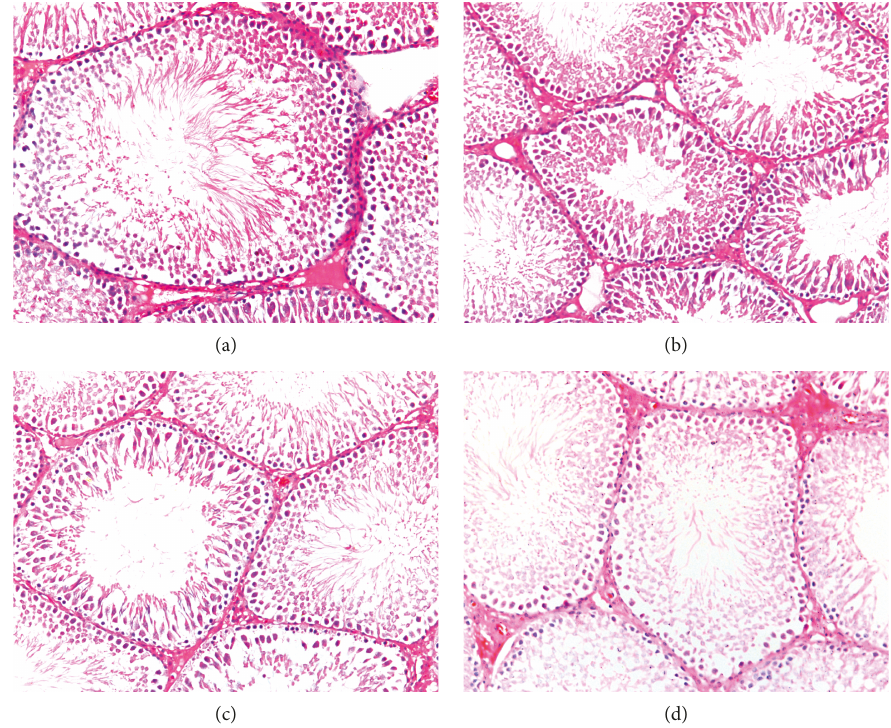
Figure 1: Representative photomicrograph of testis sections. (a, d) From the control groups. Note the regular arrangement of spermatogenic cells and seminiferous tubules. (b) From the CPA group. Note the nuclear pyknosis and cytoplasmic microvacuolization of spermatogenic cells and relatively decreased diameter of seminiferous tubules. (c) From the GnRHant+CPA group. Note the relative recovery of spermatogenic cells and seminiferous tubules. HE staining, ×